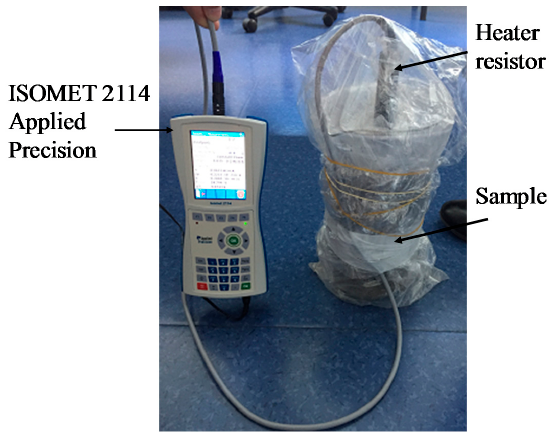
Figure 6. Thermal conductivity measurement of S ‐ BP composite.